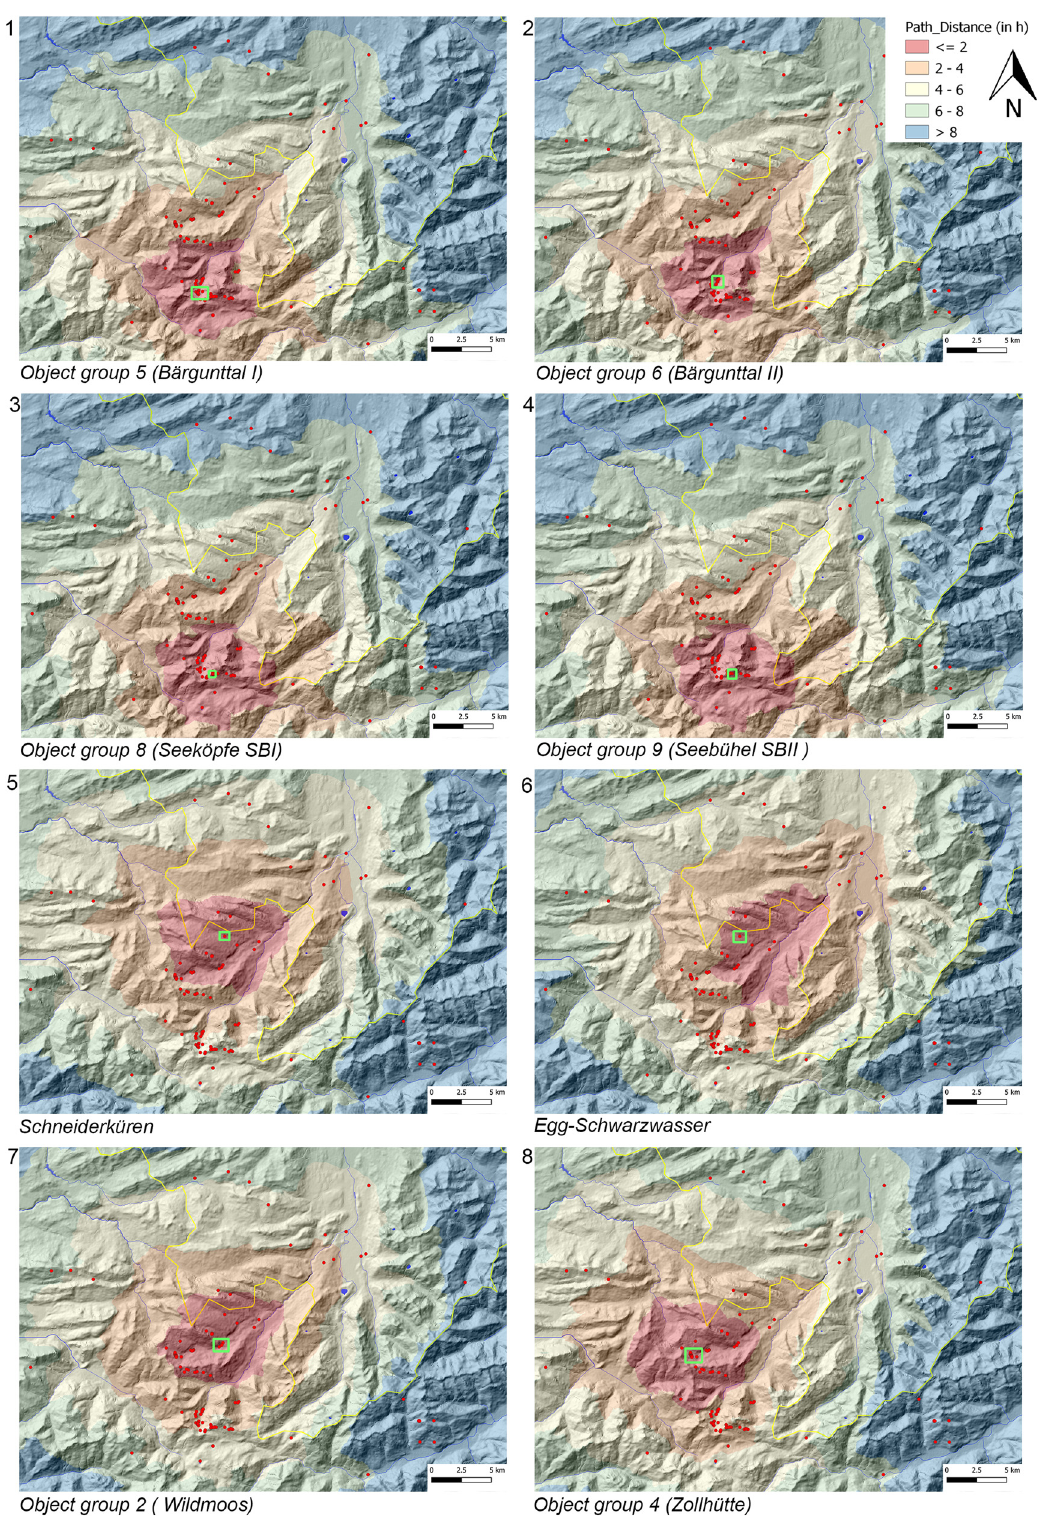
Figure 14: Two - and four - hour walking radius around the sites Schneiderküren, Egg - Schwarzwasser as well as site clusters 2 and 4 . Graphic: B. Danthine; data source: Copernicus – eu_dem_v11_E40N20 – 25 m DEM; calculated with the Tobler - Hiking - Function ( Tobler, 1993 ) in ArcGIS ( Posch, 2022 )